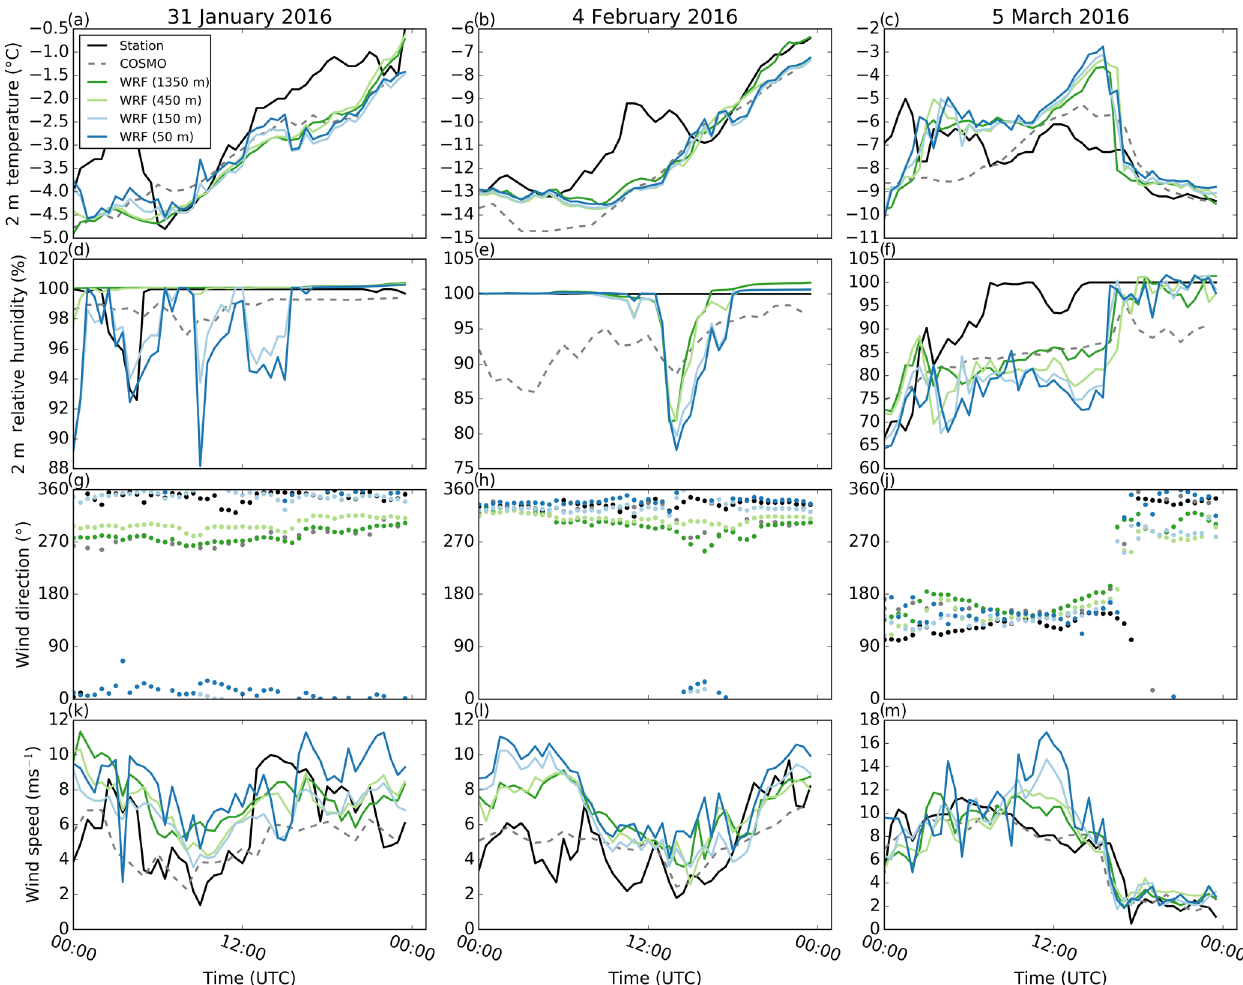
Figure 3. As in Fig. 2 but for the station FLU2 on the Flüela Pass with 5m wind speed and